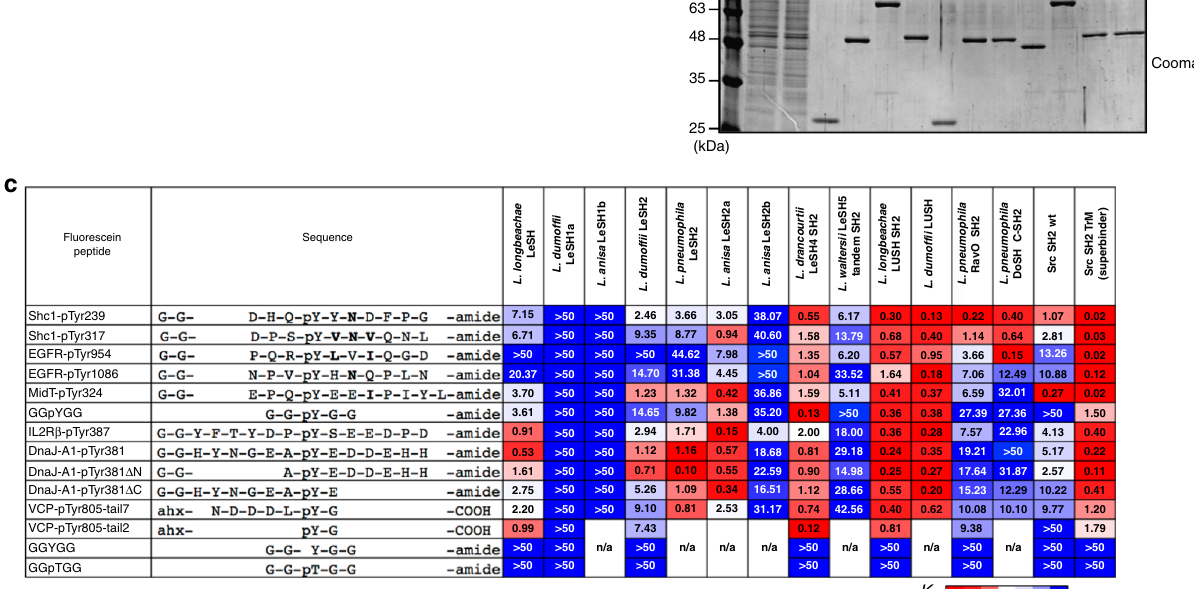
6 of the 13 Legionella SH2 domains examined exhibited <10 µM af fi nities for the mini pTyr peptide (Fig. 3b, c; Supplementary Table 2 for curve fi tting statistics). Furthermore, four of the bacterial SH2 domains bound the peptide more tightly than the Src SH2-derived superbinder. It is remarkable that the L. drancourtii LeSH4 SH2 domain bound to the GGpYGG pep- tide with 12-fold greater af fi nity than the superbinding Src SH2